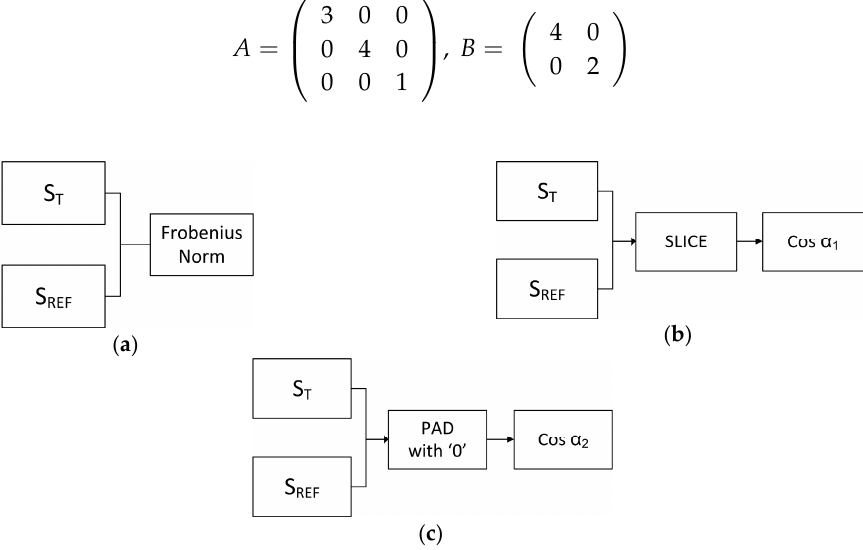
Figure 2. Features for classification: ( a ) the Frobenius norm; ( b ) angle α 1 , between vectors after slicing the longer vector and ( c ) angle α 2, between vectors after padding ‘0’ over the shorter vector.